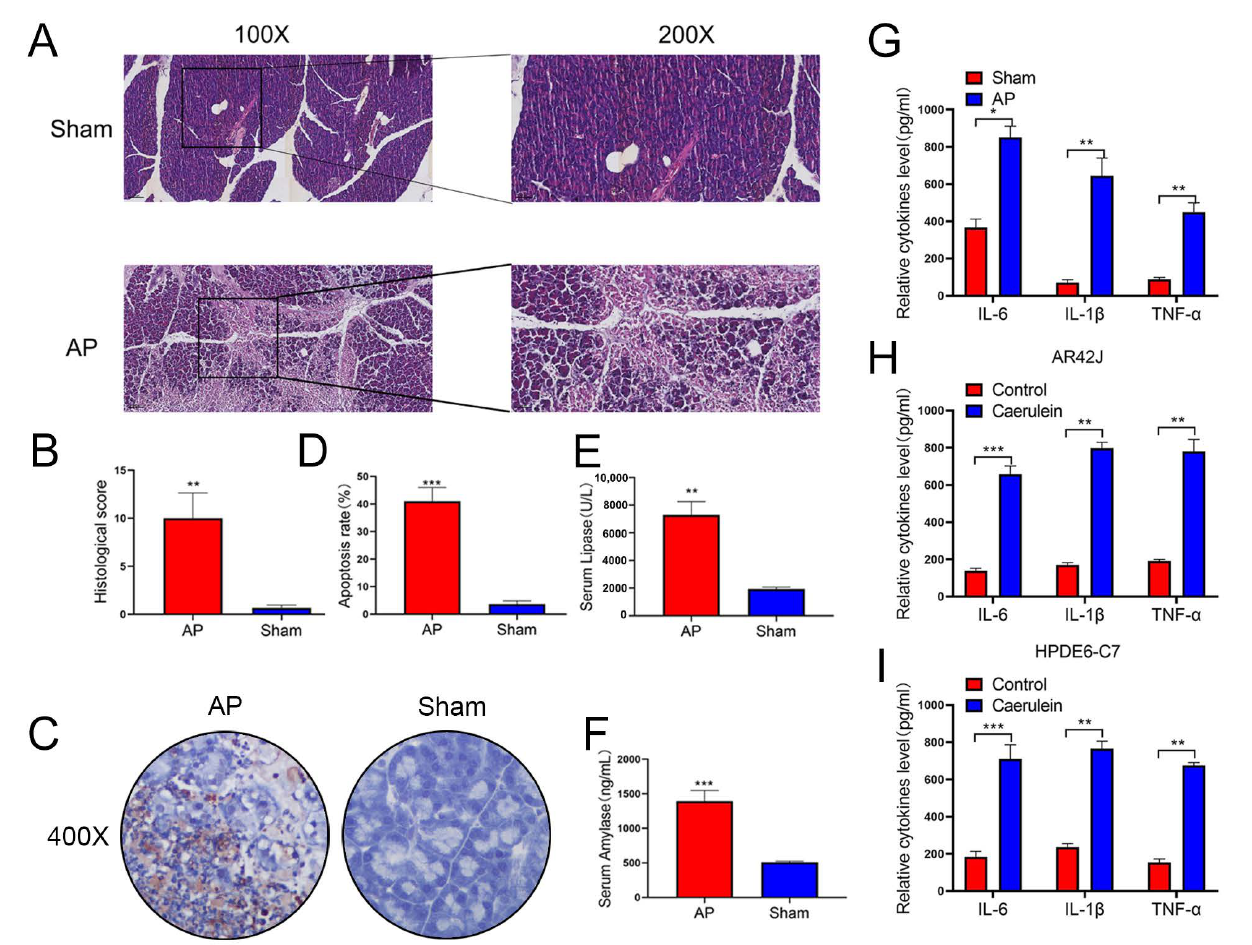
Figure 1. Successful establishment of a model of AP in Rat and cell lines. ( A , B ) The establishment of the rat model of acute pancreatitis was confirmed by HE staining, the pathological scoring was performed in two groups, n = 5 in each group, and representative images have been shown. ( C , D ) Apoptosis of pancreatic tissues in rats evaluated by TUNEL staining ( n = 5). ( E , F ) Serum levels of AMY and LIPA of rats examined by ELISA ( n = 5). ( G – I ) Expression of IL-6, TNF- α , and IL-1 β in the rats, AR42J, and HPDE6-C7 assessed by ELISA ( n = 3). The data are presented as means ± SDs, * p < 0.05; ** p < 0.01; *** p < 0.001, between the indicated